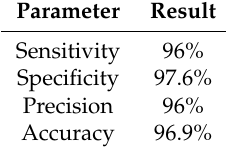
Table 2. Algorithm